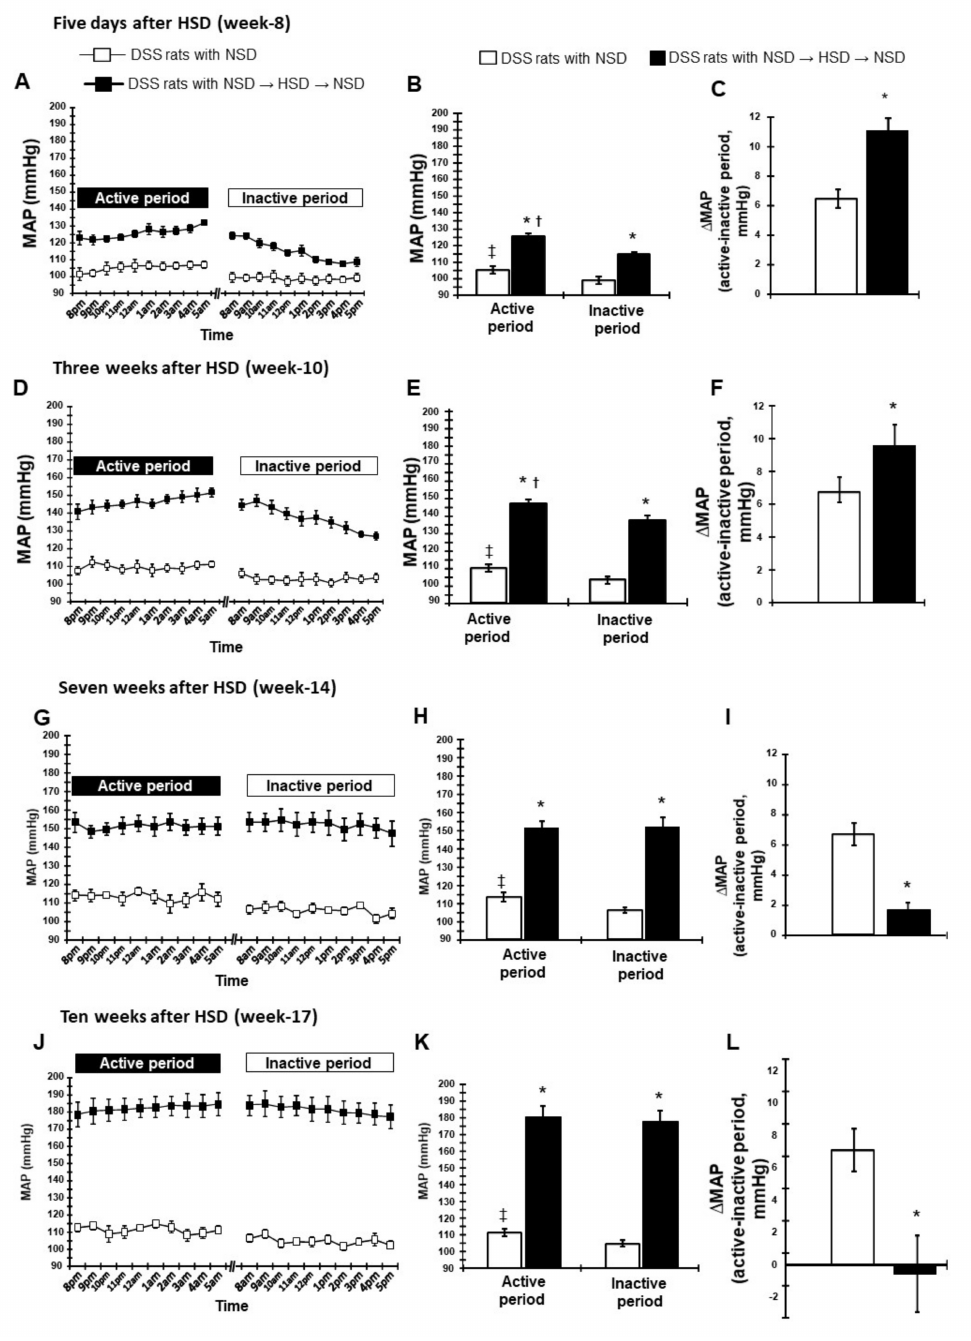
Figure 3. Circadian rhythm of MAP during feeding HSD (week 8–17). ( A ) Hourly MAP, ( B ) averaged 10-h MAP in active and inactive periods, and ( C ) the di ff erence of 10-h MAP between active and inactive periods after 5 days of HSD. ( D ) Hourly MAP, ( E ) averaged 10-h MAP in active and inactive periods, and ( F ) the di ff erence of 10-h MAP between active and inactive periods after 3 weeks of HSD. ( G ) Hourly MAP, ( H ) averaged 10-h MAP in active and inactive periods, and ( I ) the di ff erence of 10-h MAP between active and inactive periods after 7 weeks of HSD. ( J ) Hourly MAP, ( K ) averaged 10-h MAP in active and inactive periods, and ( L ) the di ff erence of 10-h MAP between active and inactive periods after 10 weeks of HSD in DSS rats. * p < 0.05 vs. DSS rats with NSD; † p < 0.05, DSS rats with NSD → HSD → NSD (inactive period) vs. DSS rats with NSD → HSD → NSD (active period); ‡ p < 0.05, DSS rats with NSD (inactive period) vs. DSS rats with NSD (active